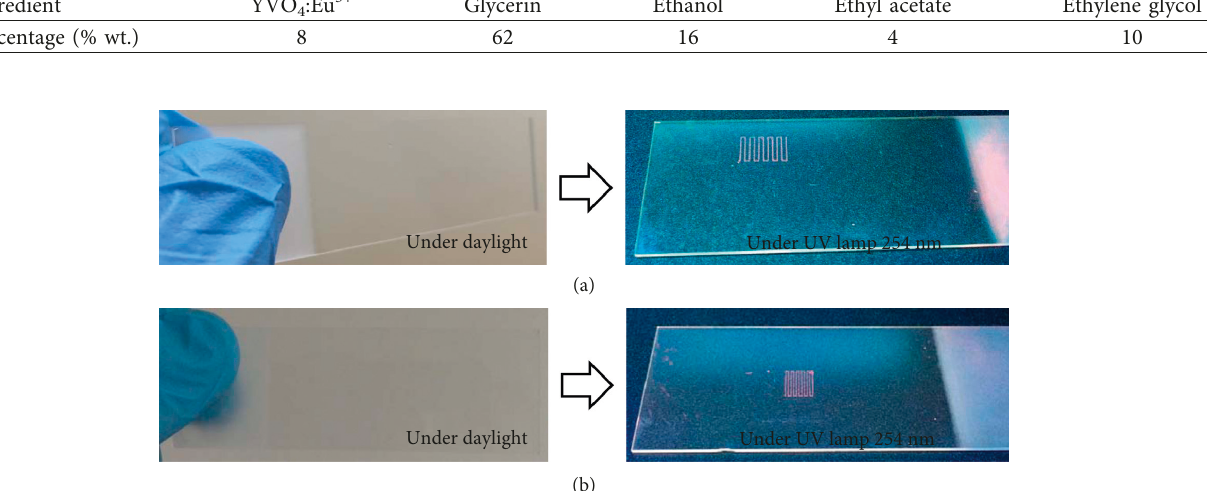
Figure 11: The image of lines under daylight and UV lamp, labels with distance between two lines at 300 μ m (a) and 800 μ m (b).